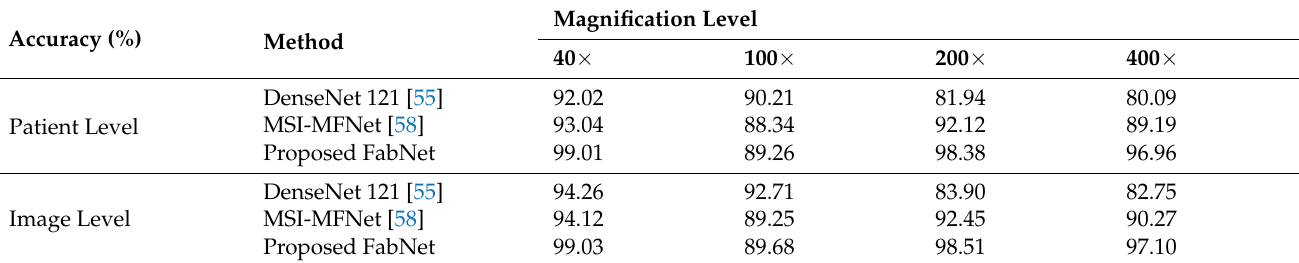
Table 4. Performance comparisons in terms of accuracy for BreakHis